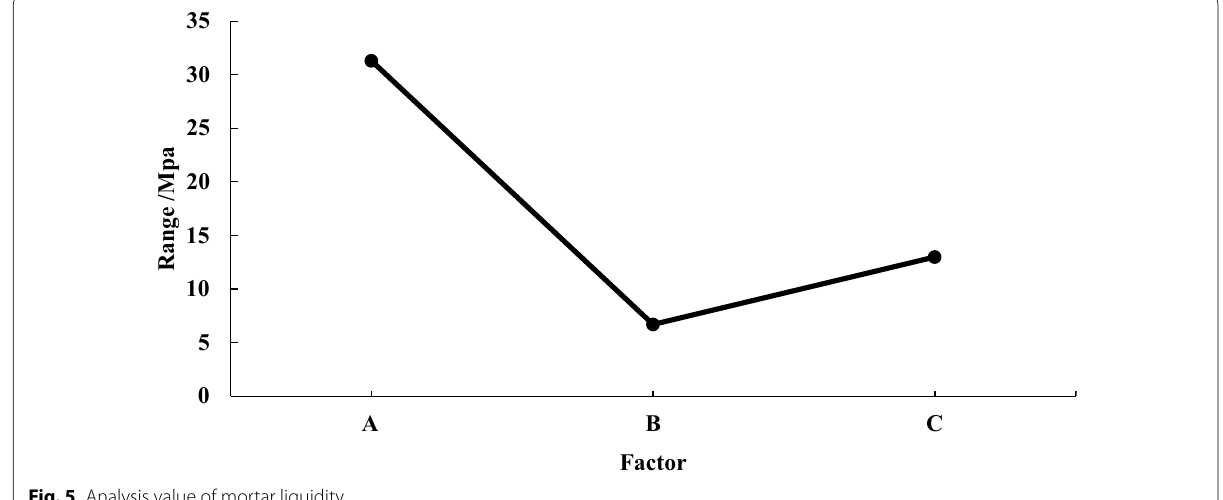
Fig. 5 Analysis value of mortar liquidity.